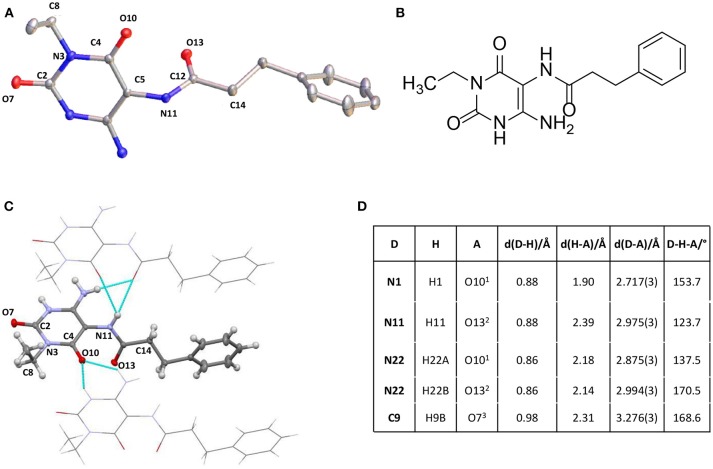
(A) Crystal structure of 6-amino-5-carboxamidouracil 32. (B) Structure of 32. (C) Intermolecular interactions building the crystal structure of 32. (D) Most important intermolecular hydrogen bonds of 32. Supporting Material Data Sheet 2.